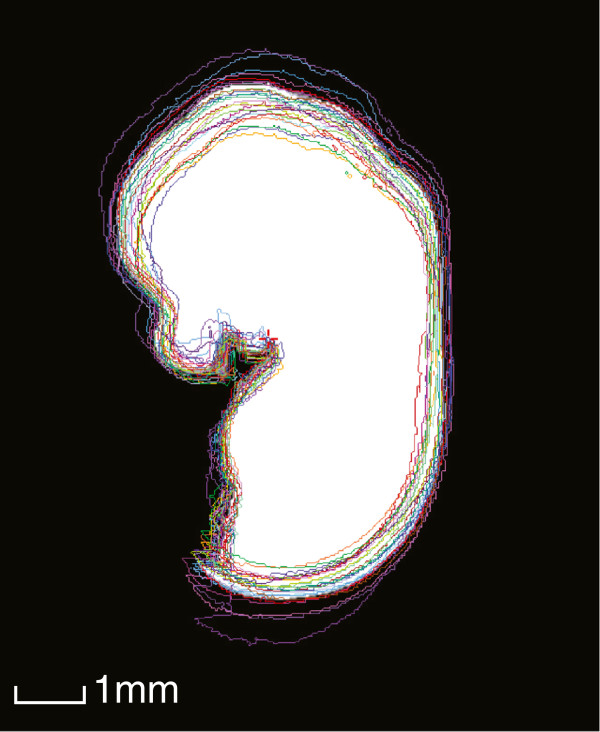
An illustration of the animal-to-animal variation within the SD group at E13.5. The coloured traces are outlines of all linearly-aligned individual SD images, and the white region is a mask of the final average image.